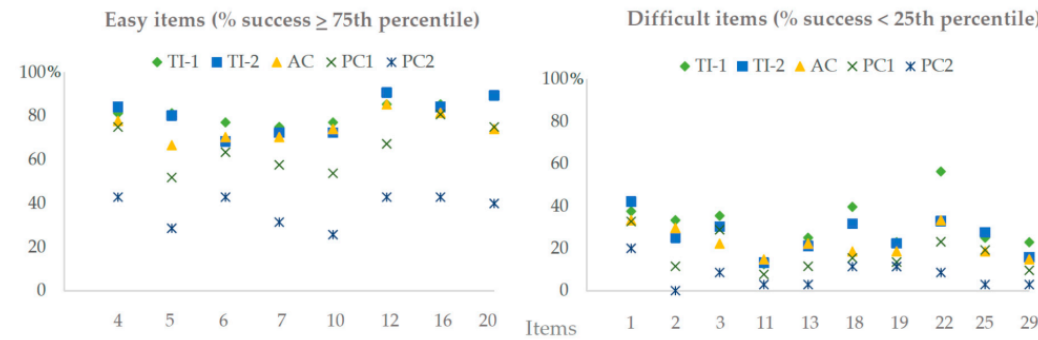
Figure 4. Percentage of participants, as a function of intervention type, who correctly responded to either easy or di ffi cult items in the